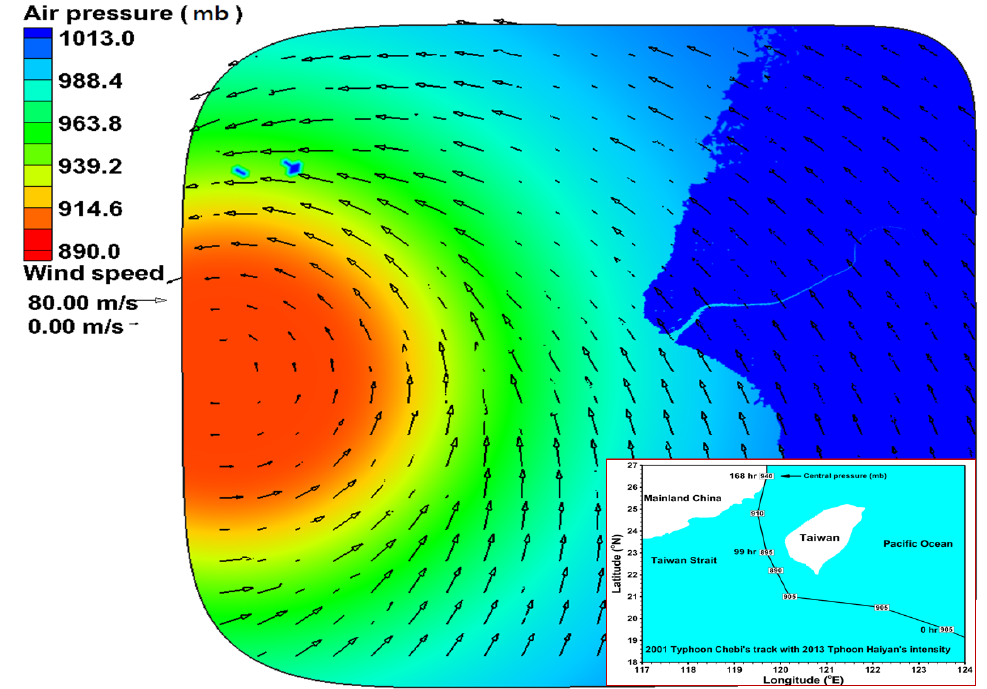
Figure 7. Distribution of air pressure and wind speed generated from the prototypical typhoon model used in a numerical experiment (using tracks of Typhoon Chebi in 2001 and intensity of Typhoon Haiyan in 2013). The center pressure and time of typhoon track show in the small